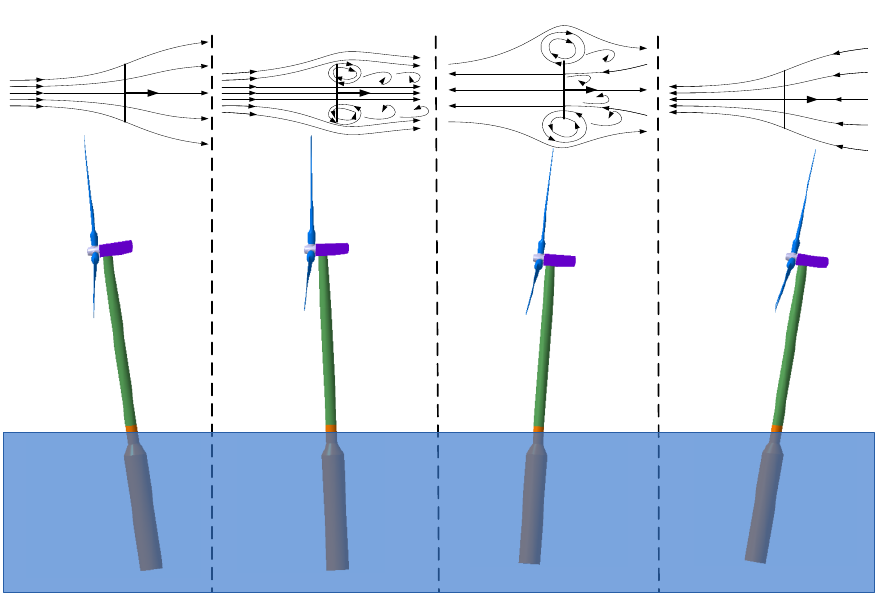
Figure 2. Platform pitching motion and its effects on the surrounding